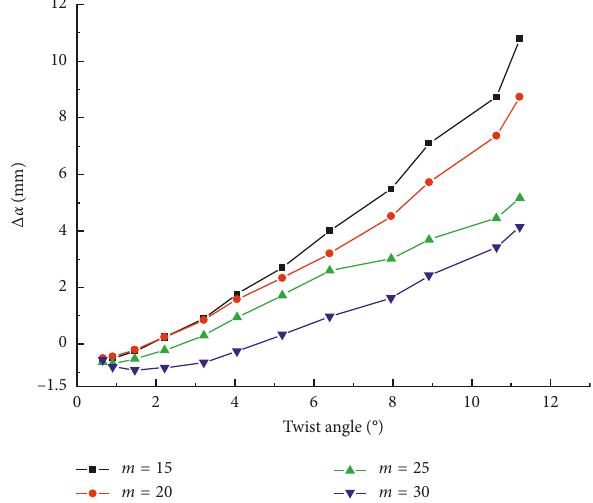
Figure 10: The total springback value of the profile with the change of twist